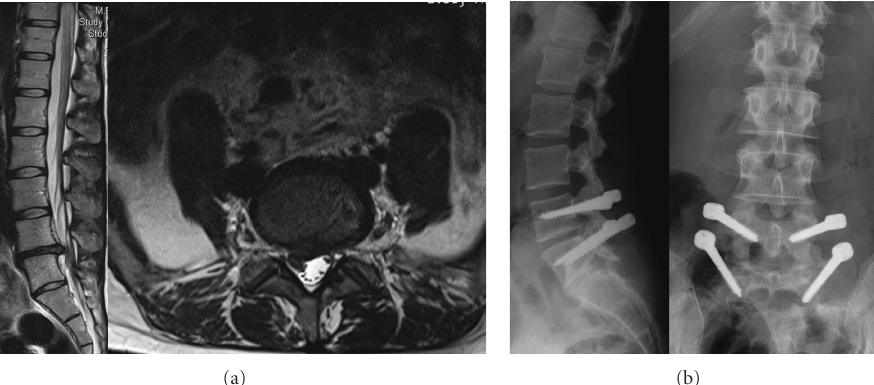
Figure 3: 34-year-old female patient with right leg pain and back pain. (a) T2 weighted MRI scans show L4-5 disc herniation; (b) the Dynesys system was applied.